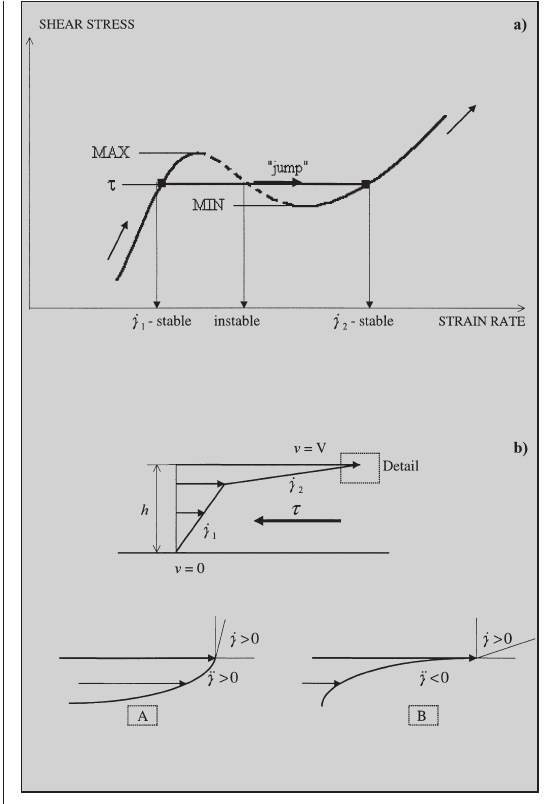
Figure 3 (left): a) Steady non-monotone